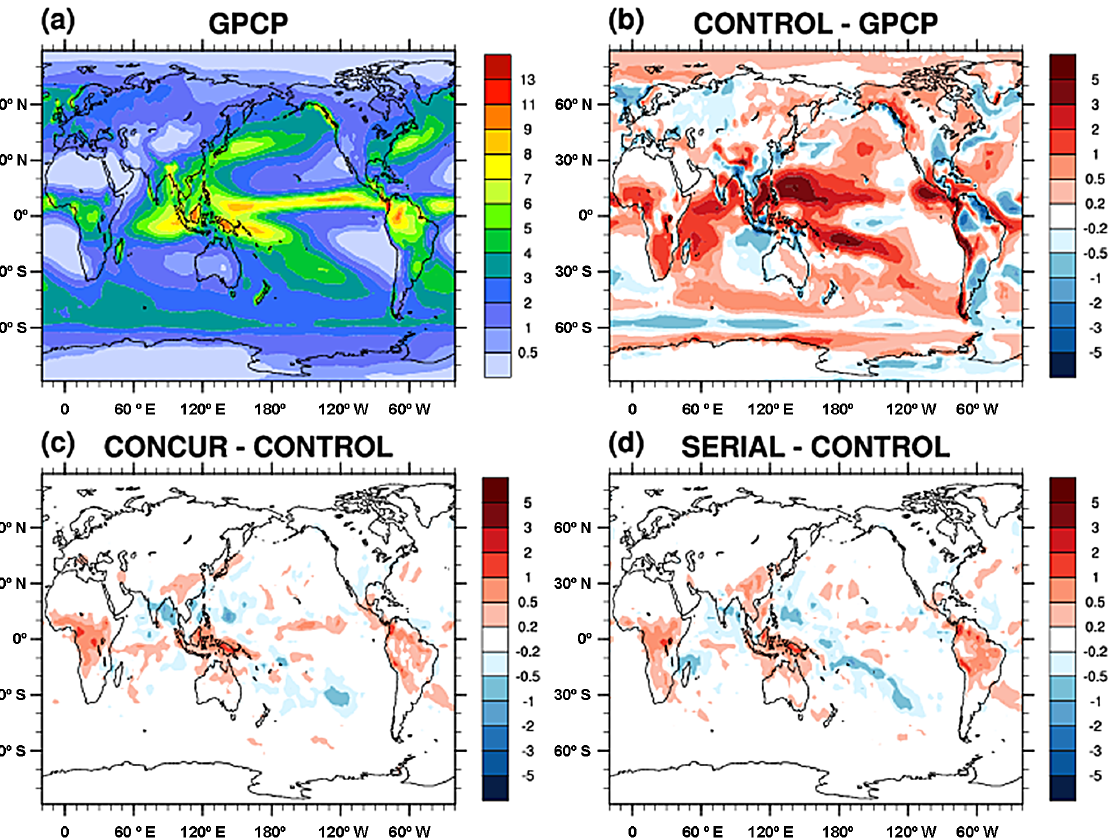
Figure 5. Comparison of model climatologies against GPCP precipitation. (a) shows the GPCP climatology, and (b) the model climatological biases for the CONTROL run. Panels (c) and (d) show model–model difference vs. CONTROL for CONCUR and SERIAL runs plotted on the same color scale as (b)